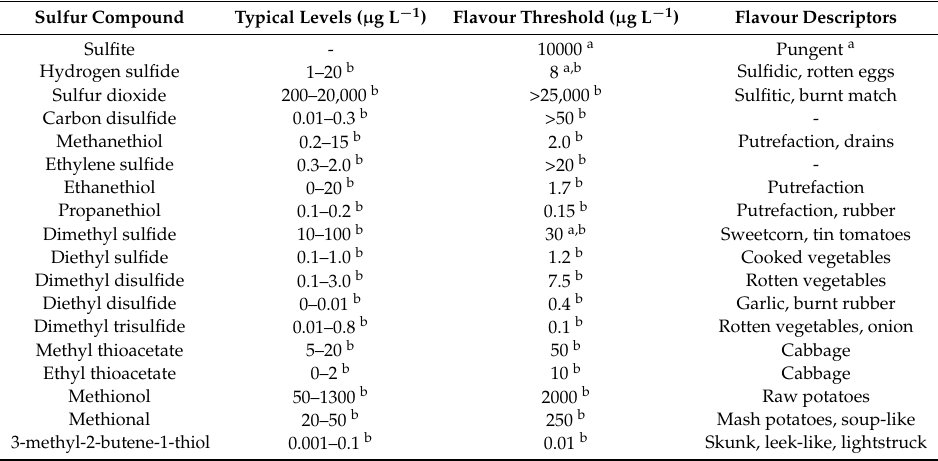
Figure 3. Formation of diacetyl and 2,3-pentanedione. Table 6. Volatile sulfur compounds commonly found in